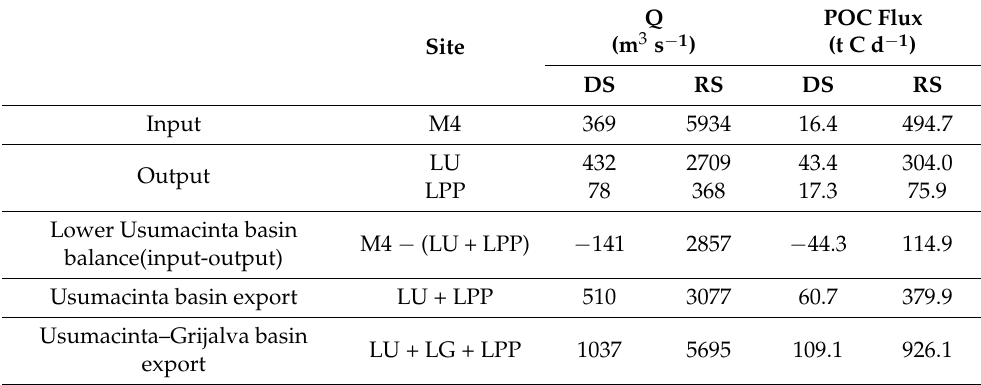
Table 3. Input–output balances of water discharge (Q) and POC in the Usumacinta lower basin and the total POC export to the Gulf of Mexico in the rainy (RS) and dry (DS) seasons of 2017. M4 is the output of the middle basin; LU: Usumacinta River; LG: Grijalva River, LPP: San Pedro–San Pablo River. See Figure 1 for the detailed locations of the sampling